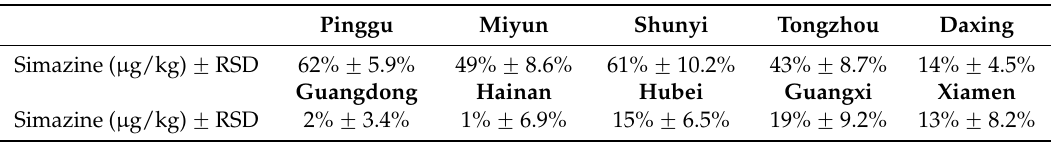
Table 2. Concentrations of simazine residue in actual